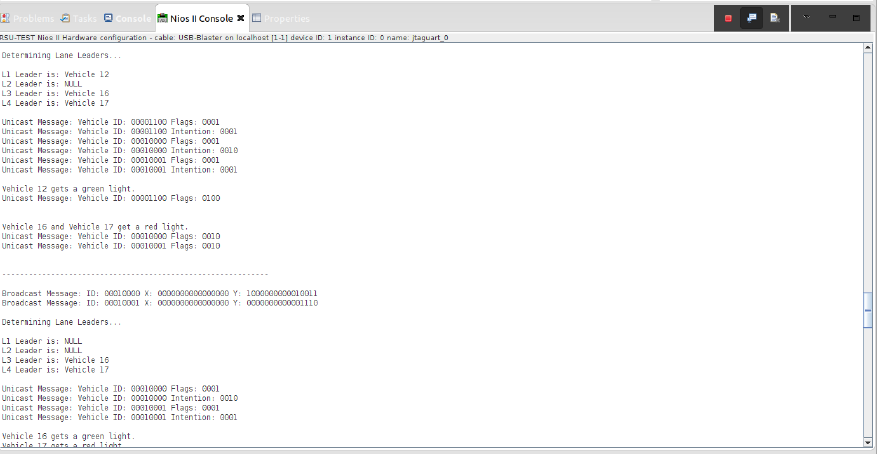
Figure 16. The above screenshot from the Nios II Eclipse Console demonstrates the successful traffic management for scenarios of three vehicles and two vehicles at the blind intersection.